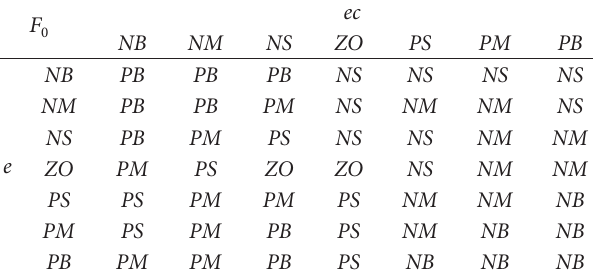
Table 1: Fuzzy control